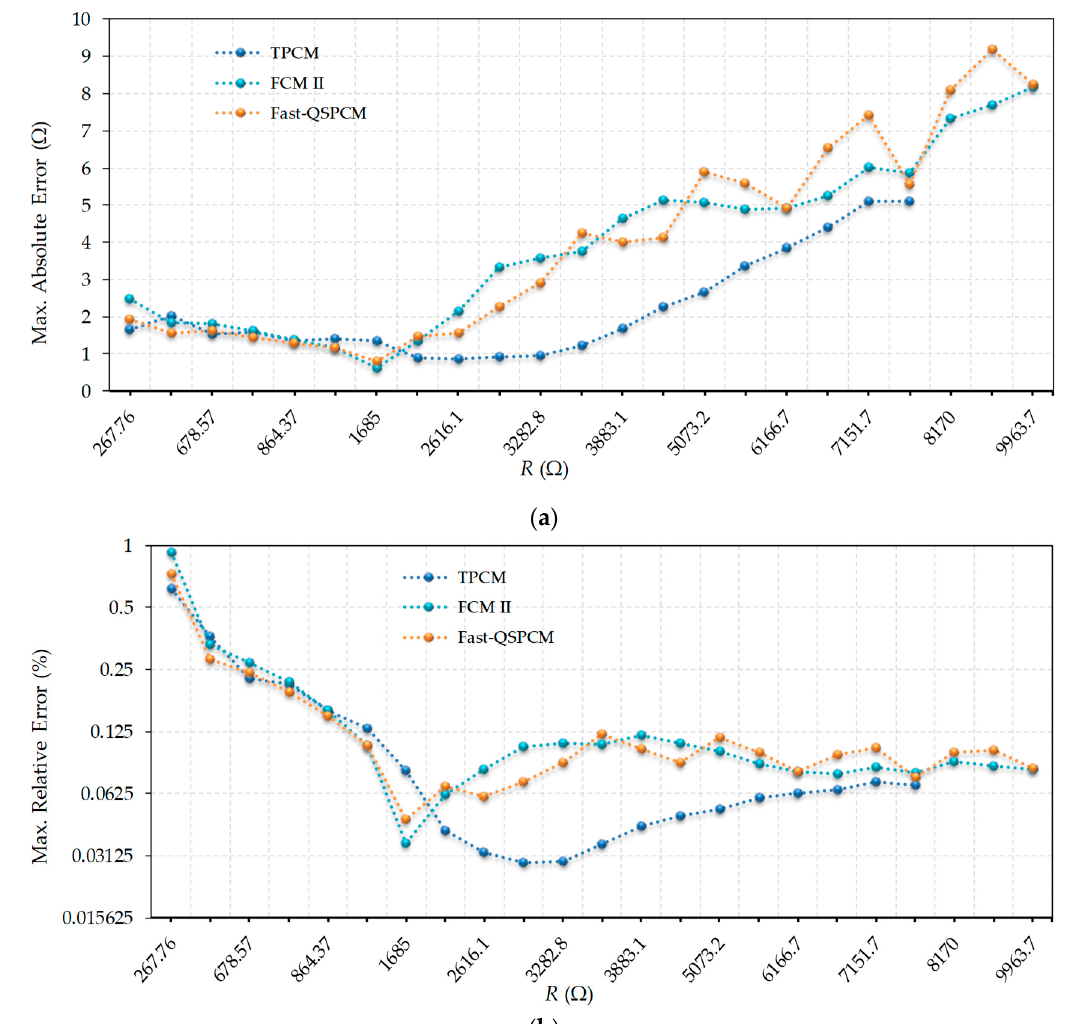
Figure 3. Errors in estimating resistance values using the TPCM, FCM II, and Fast-QSPCM: ( a ) absolute maximum errors (linear scale); ( b ) relative maximum errors (log2 scale).